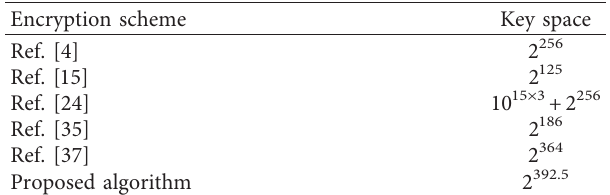
Table 2: Key space comparative